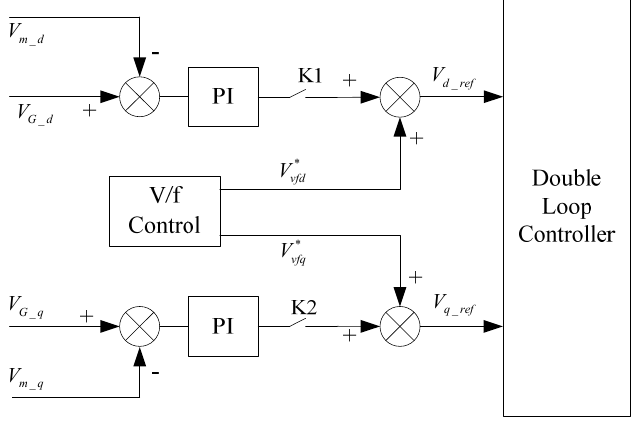
Figure 9. Structure of Improved Pre ‐ Synchronous Controller.